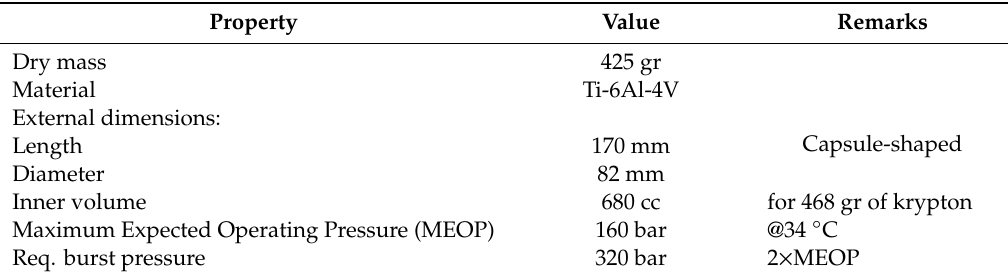
Table 3. Propellant tank properties.